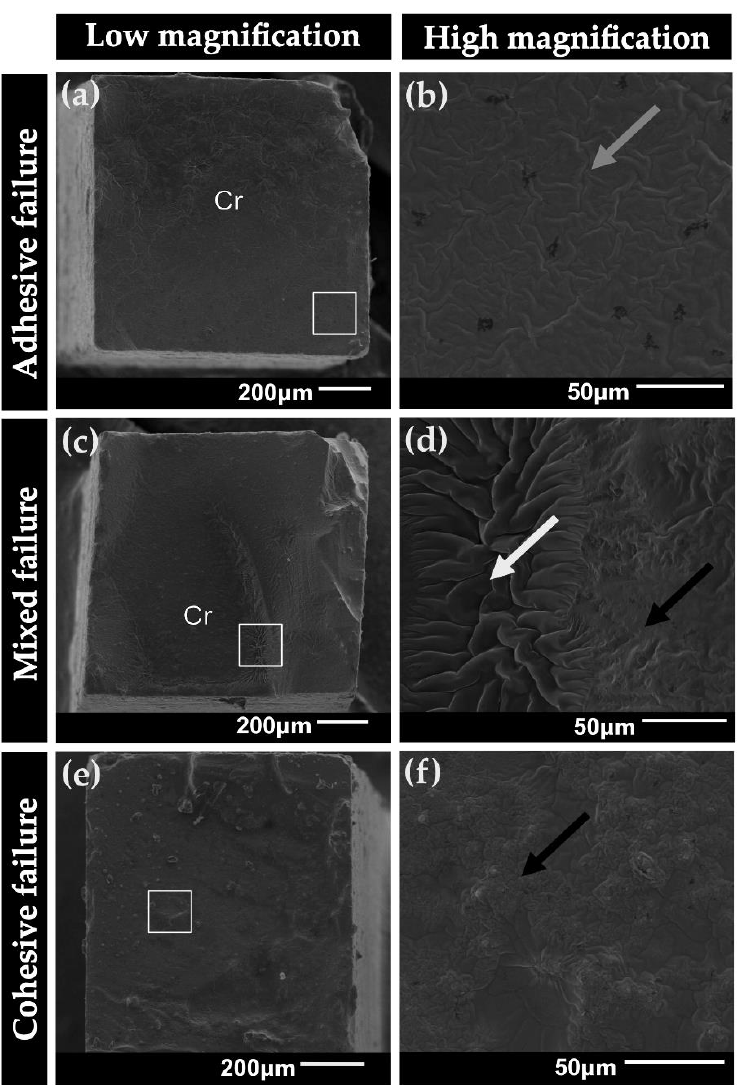
crobeams of following groups: control (no priming), MBN, SBU, and SBP.